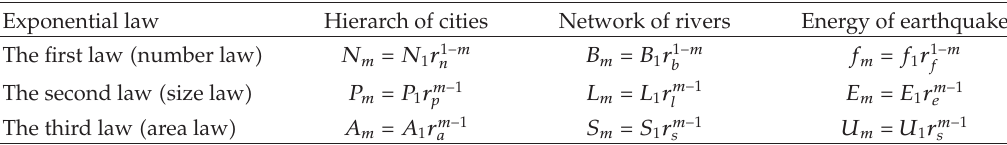
Table 1: Comparison between the exponential laws of cities and those of rivers and earthquake energy. Exponential law Hierarch of cities Network of rivers Energy of